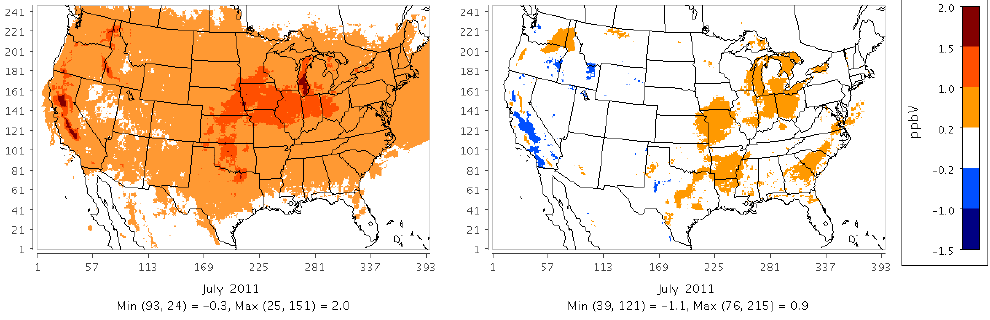
Figure 12. Difference in monthly mean MDA8 O 3 perturbation between: (a) BDSNP (“old”) – YL (left) and (b) BDSNP (“new”) – BDSNP (“old”) (right). MDA8 O 3 perturbations are from perturbed anthropogenic NO x estimates 2011 base case to 2025 base case, BAU (US EPA,